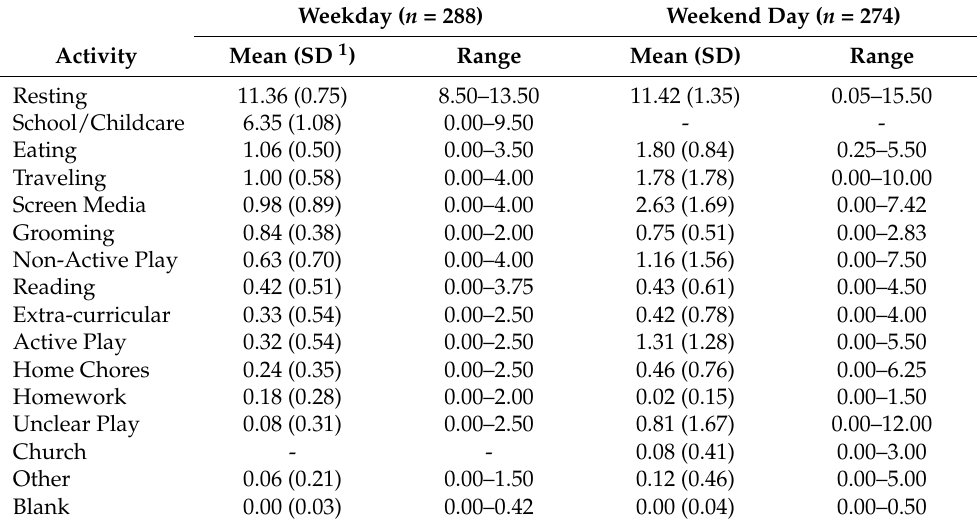
Table 2. Descriptive statistics in hours for time delegation to diary activities on weekdays versus weekend